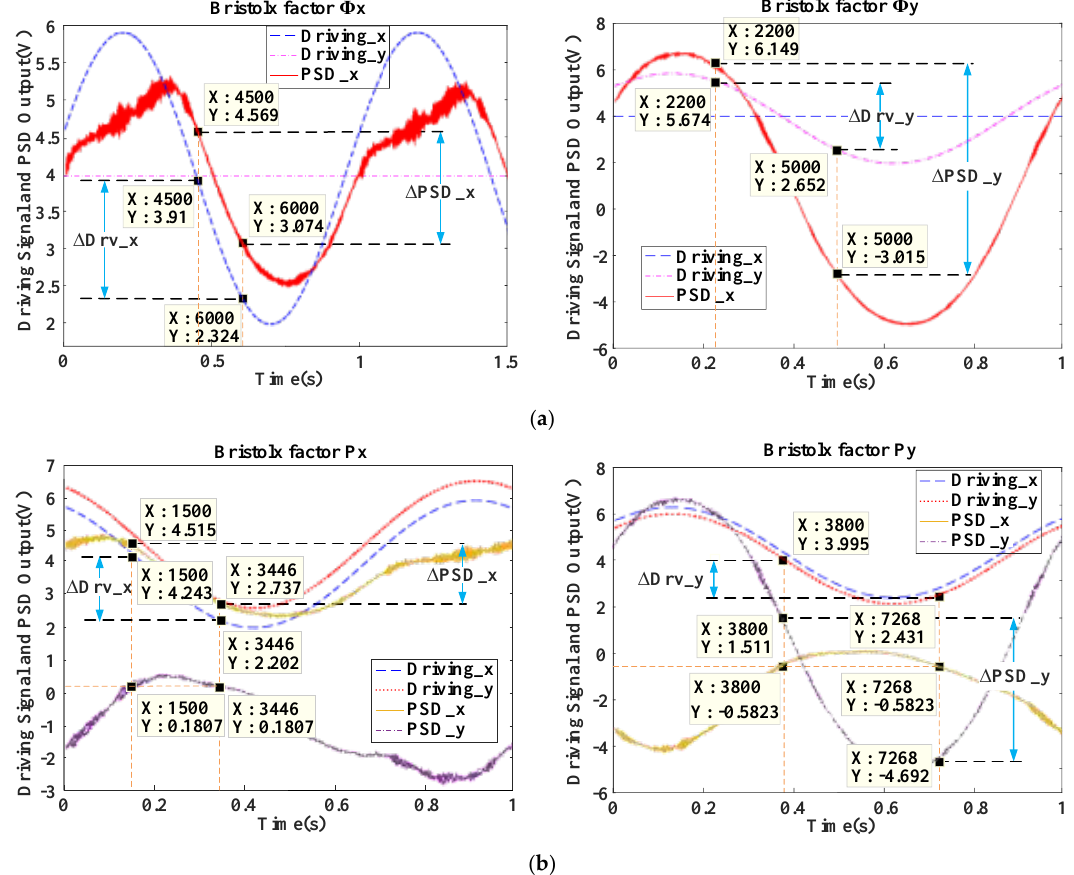
Figure 4. ( a ) Signals for calculating Bristolx factors Φ of X/Y direction; ( b ) signals for calculating Bristolx factors P of X/Y direction.